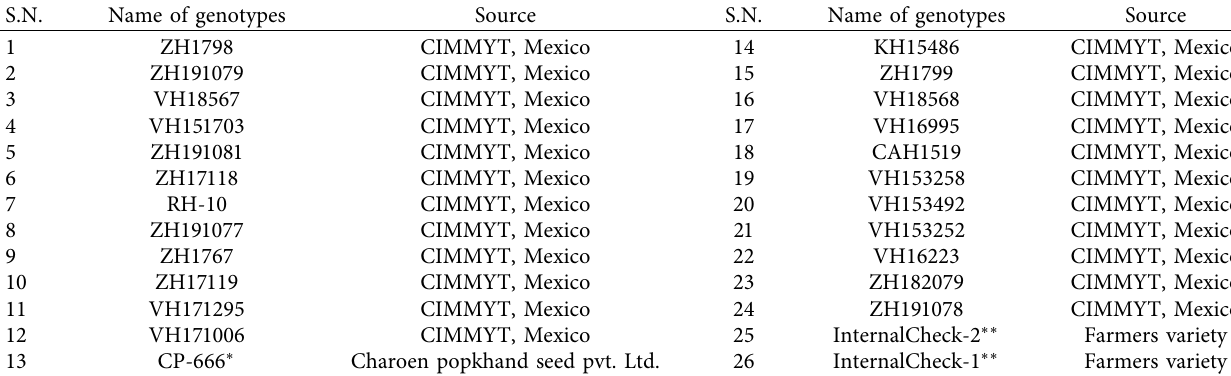
Table 1: Details of the genetic materials